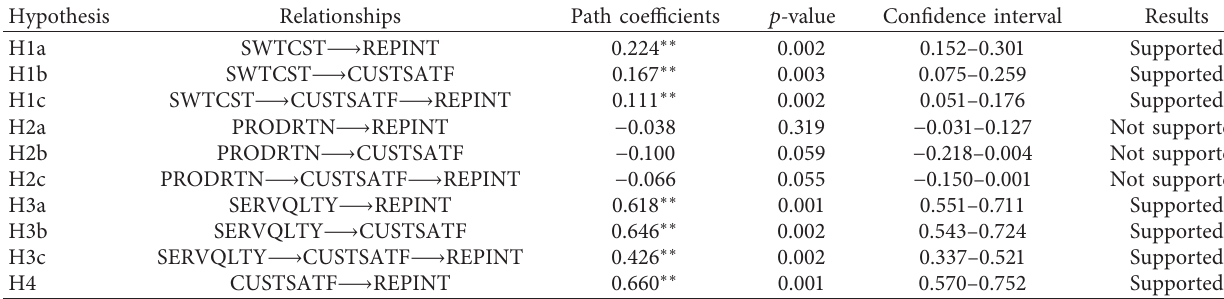
Table 11: Hypothesis testing result summary.